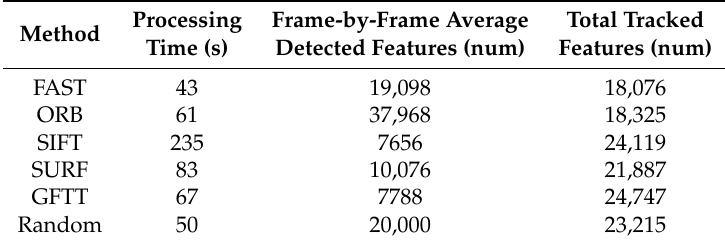
Table 2. Frame-by-frame average number of detected features and total number of tracked features with optical tracking velocimetry (OTV) and six different feature detectors for a representative image sequence of 500 frames on the Brenta